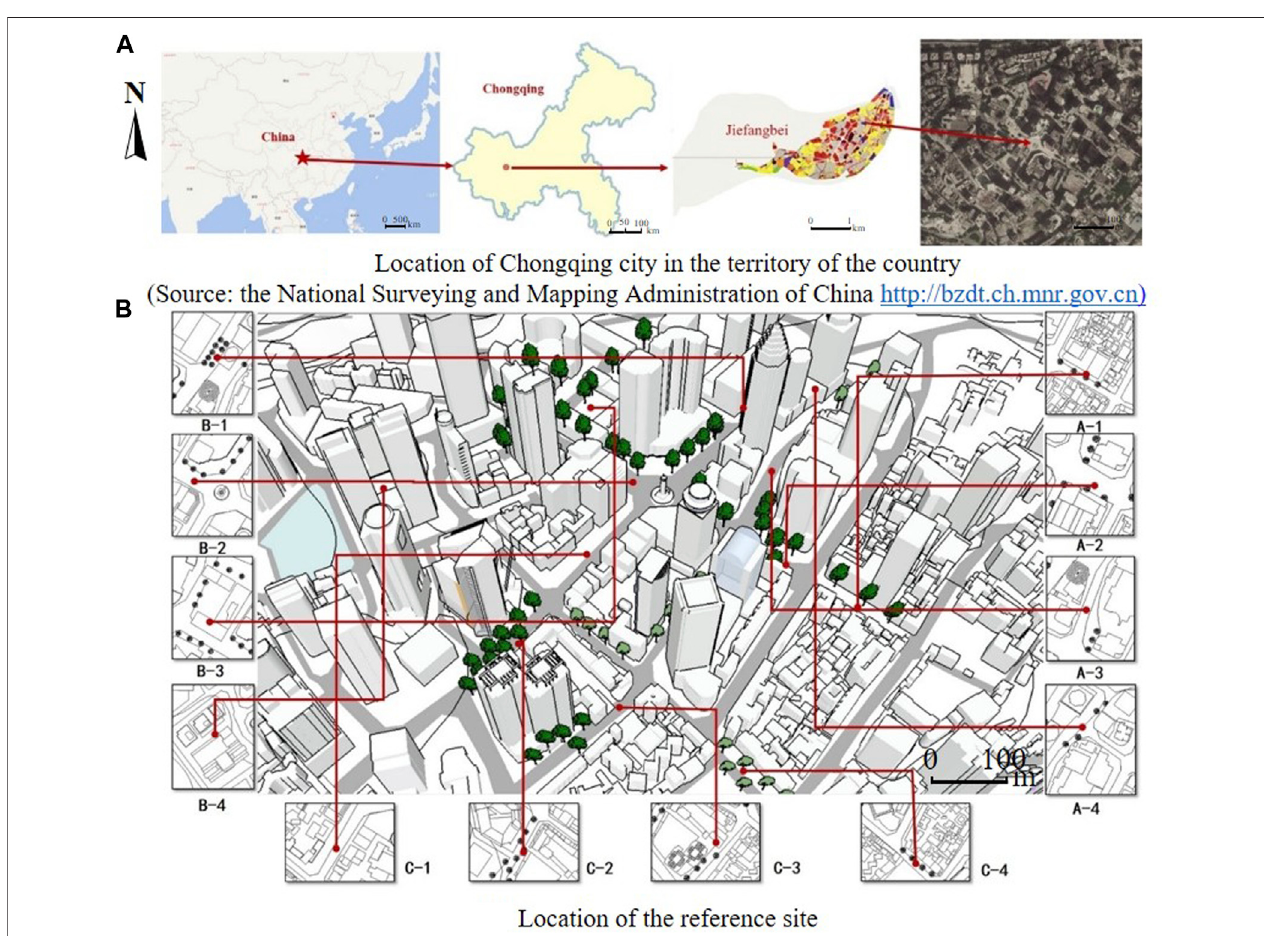
FIGURE 2 | Location of Chongqing city (A) and the reference site (B)